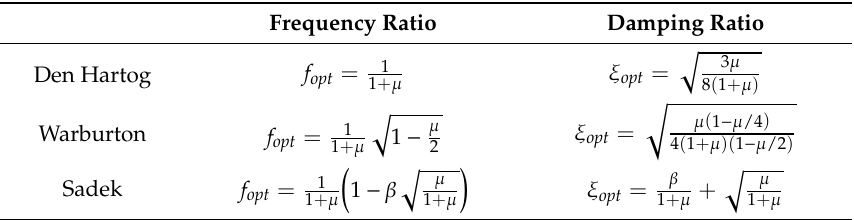
Table 4. Optimum parameters suggested for the TMD